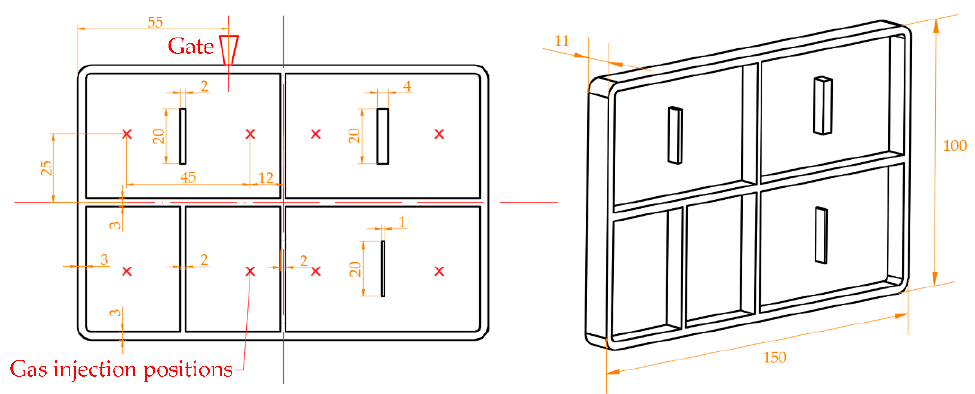
Figure 1. Dimensions of the parts and locations of the gate and gas injection positions (unit: mm).